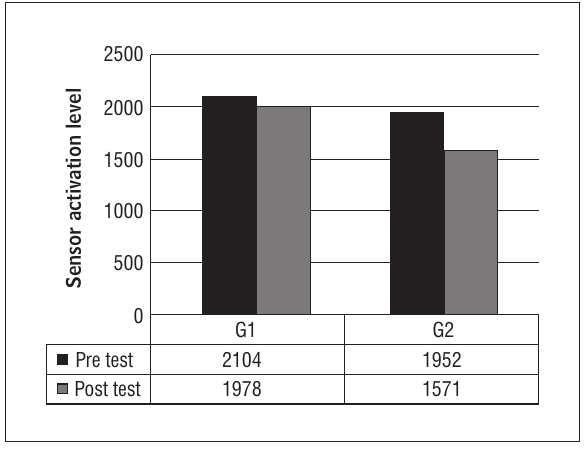
Figure 3 - Comparison between the groups, average values of oscillation on the balance board with feet apart, before and after the treatment